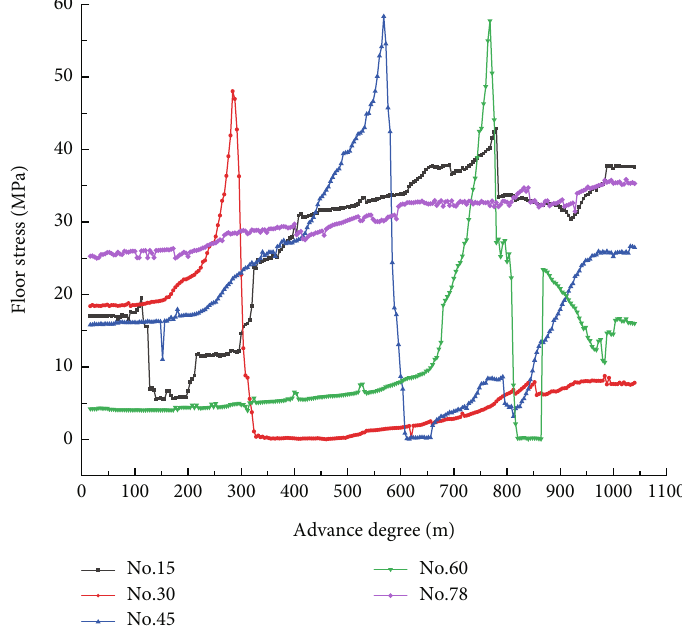
Figure 17: Pressure changes at di ff erent measuring points during the advancing of the 222 working